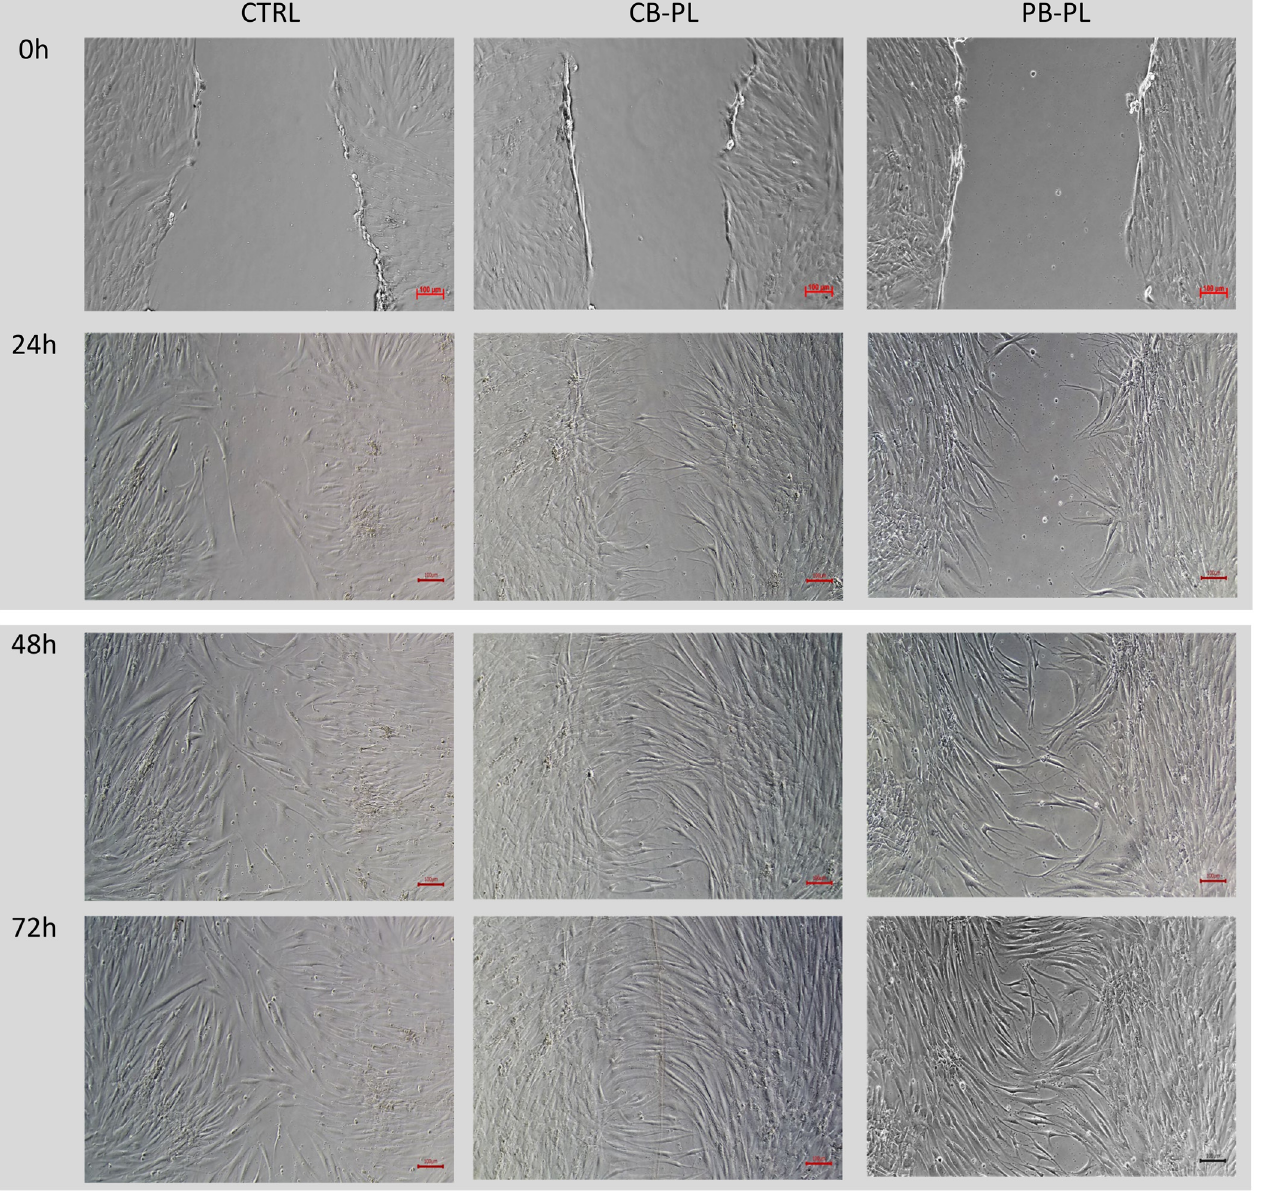
Figure 3. Phase contrast micrographs of scratch test showed the effect of CTRL, 1.25% CB-PL and 0.3125% PB-PL towards the migration of HOMF under 100 × magnification. The wound closure was assessed after 24, 48 and 72 h of exposure to culture medium. The wounds were closed faster in 1.25% CB-PL and 0.3125% PB-PL compared to the